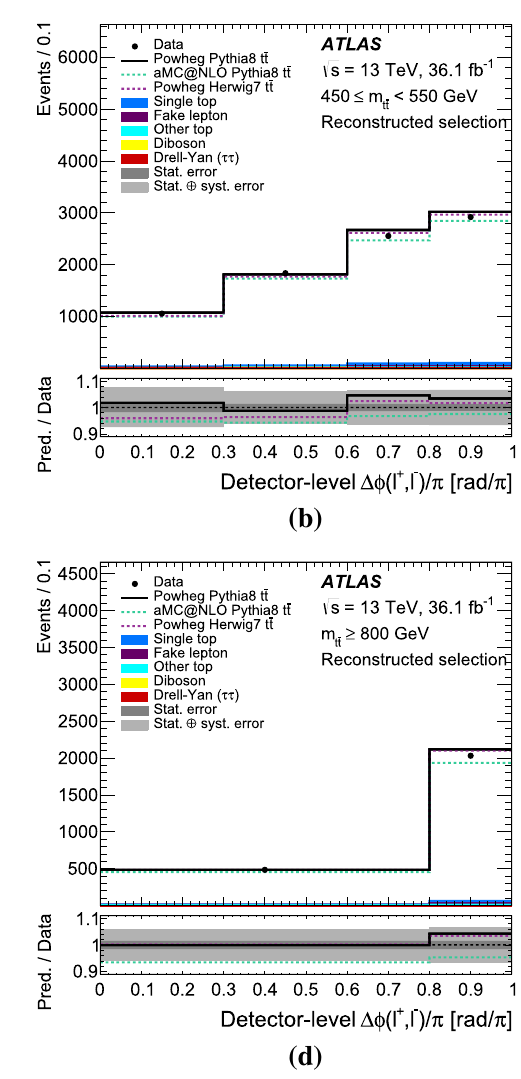
uncertainties include contributions from leptons, jets, missing trans- verse momentum, background modelling, pile-up modelling and lumi- nosity, but not PDF or signal t ¯ t modelling uncertainties. The observed distributioniscomparedtothesumofsignalandbackgroundusingthree different t ¯ t signal models: Powheg + Pythia 8, Powheg + Herwig 7 and MadGraph5 _aMC@NLO + Pythia 8, and the ratio panel com- pares the summed prediction to data for the three